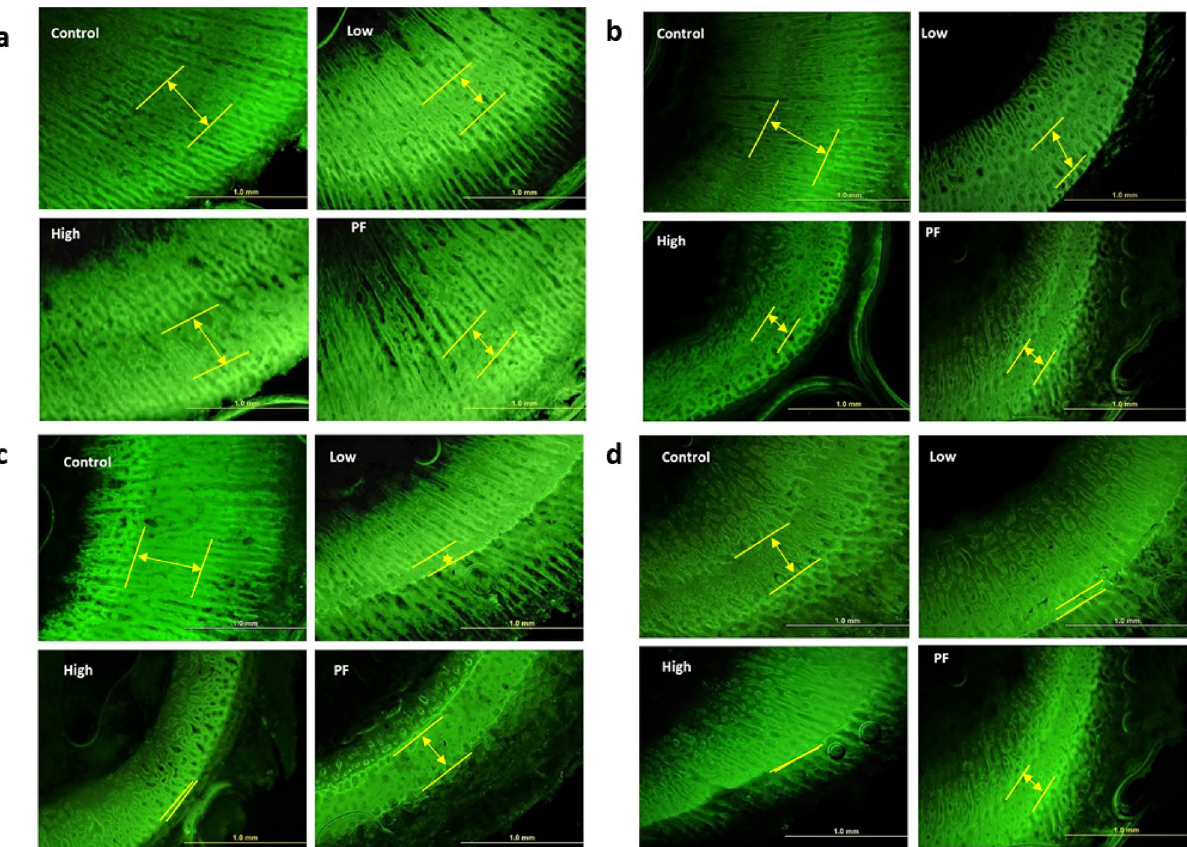
Figure 2. Fluorescence image of the femoral or tibial cross-section of broilers (measurement data shown as Table 3). Bone formation was visualized by double calcein labeling in the femoral bone and tibia bone, respectively. Representative picture ( a ): femoral bone at 0–4 dpi; ( b ): tibial bone at 0–4; ( c ): femoral bone at 4–8 dpi; ( d ): tibial bone at 4–8 dpi; Photos were taken at 4 × objective. The yellow scale bar is 1 mm in length. The yellow lines marked the distance between two calcein